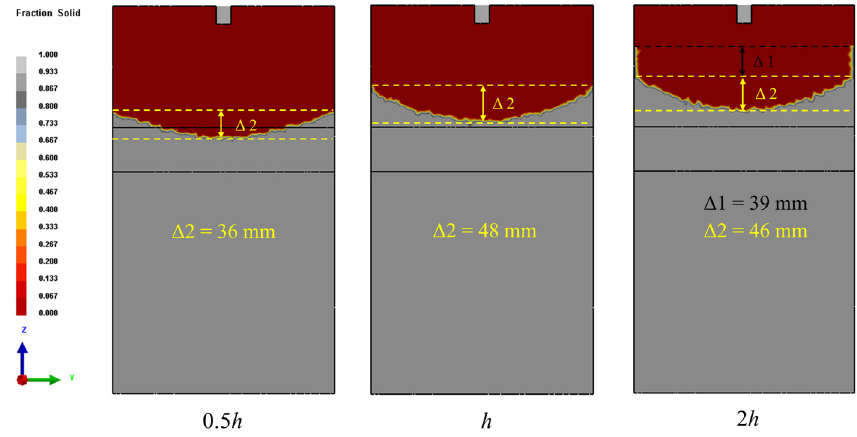
Figure 16. The shape and the depth of liquid sump with different heat transfer coefficient.